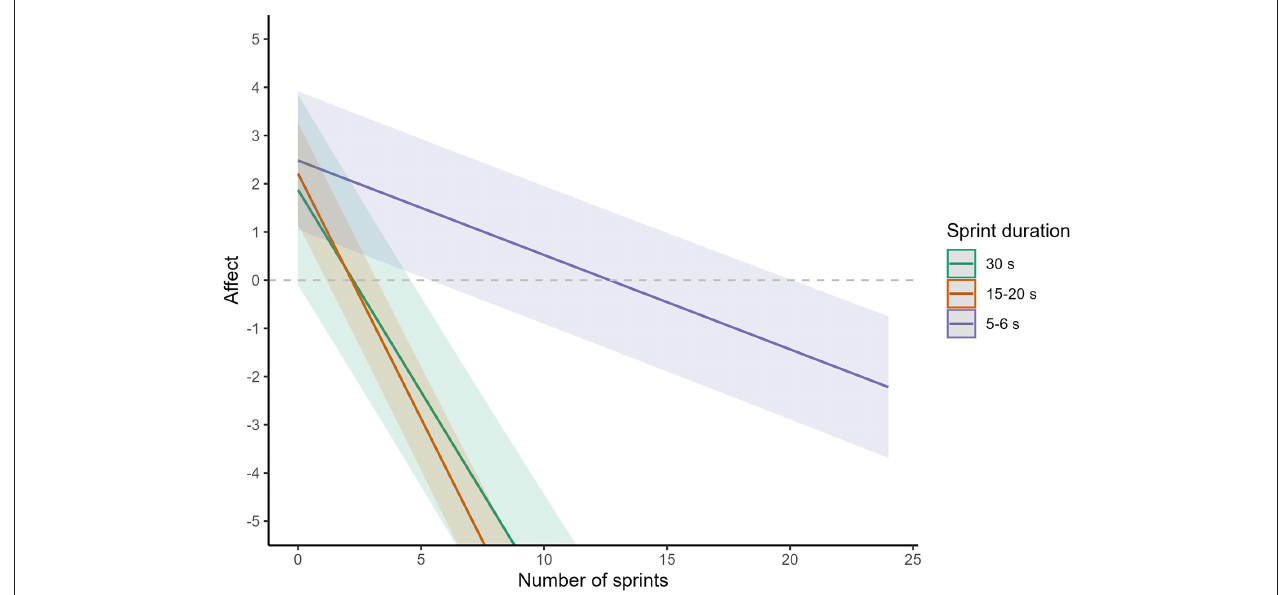
FIGURE 3 | Meta-analysis of the decrease in affective valance during SIE using different sprint durations. The solid line represents the point estimate, whilst the shaded area represents the Bonferroni corrected 95% confidence limits. The purple line and shading are for 5–6s sprints, the red line and shading are for 15–20s sprints, and the green line and shading are for 30s